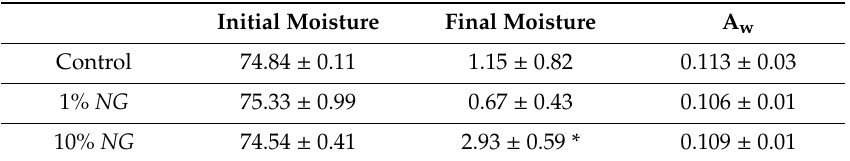
Table 6. E ff ect of NG inclusion on Initial moisture, final moisture and Aw of lyophilized Salmon meat enriched with Nannochloropsis gaditana